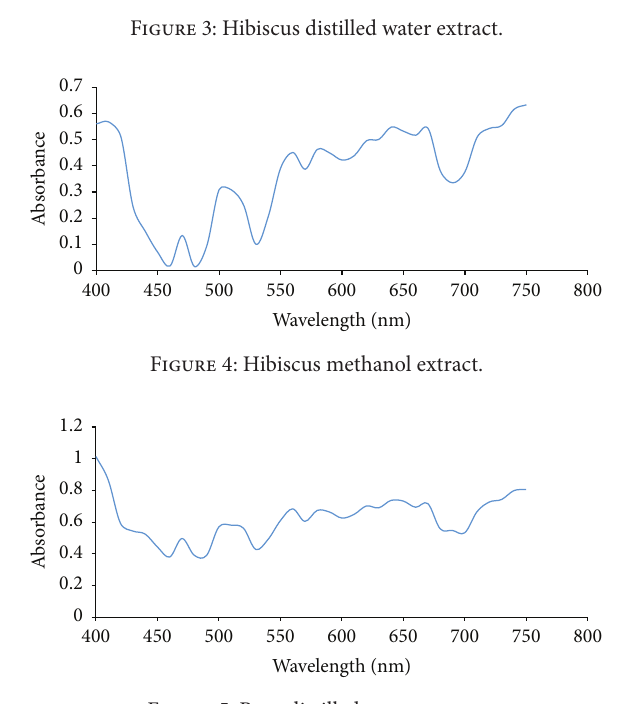
Figure 5: Rose distilled water extract.